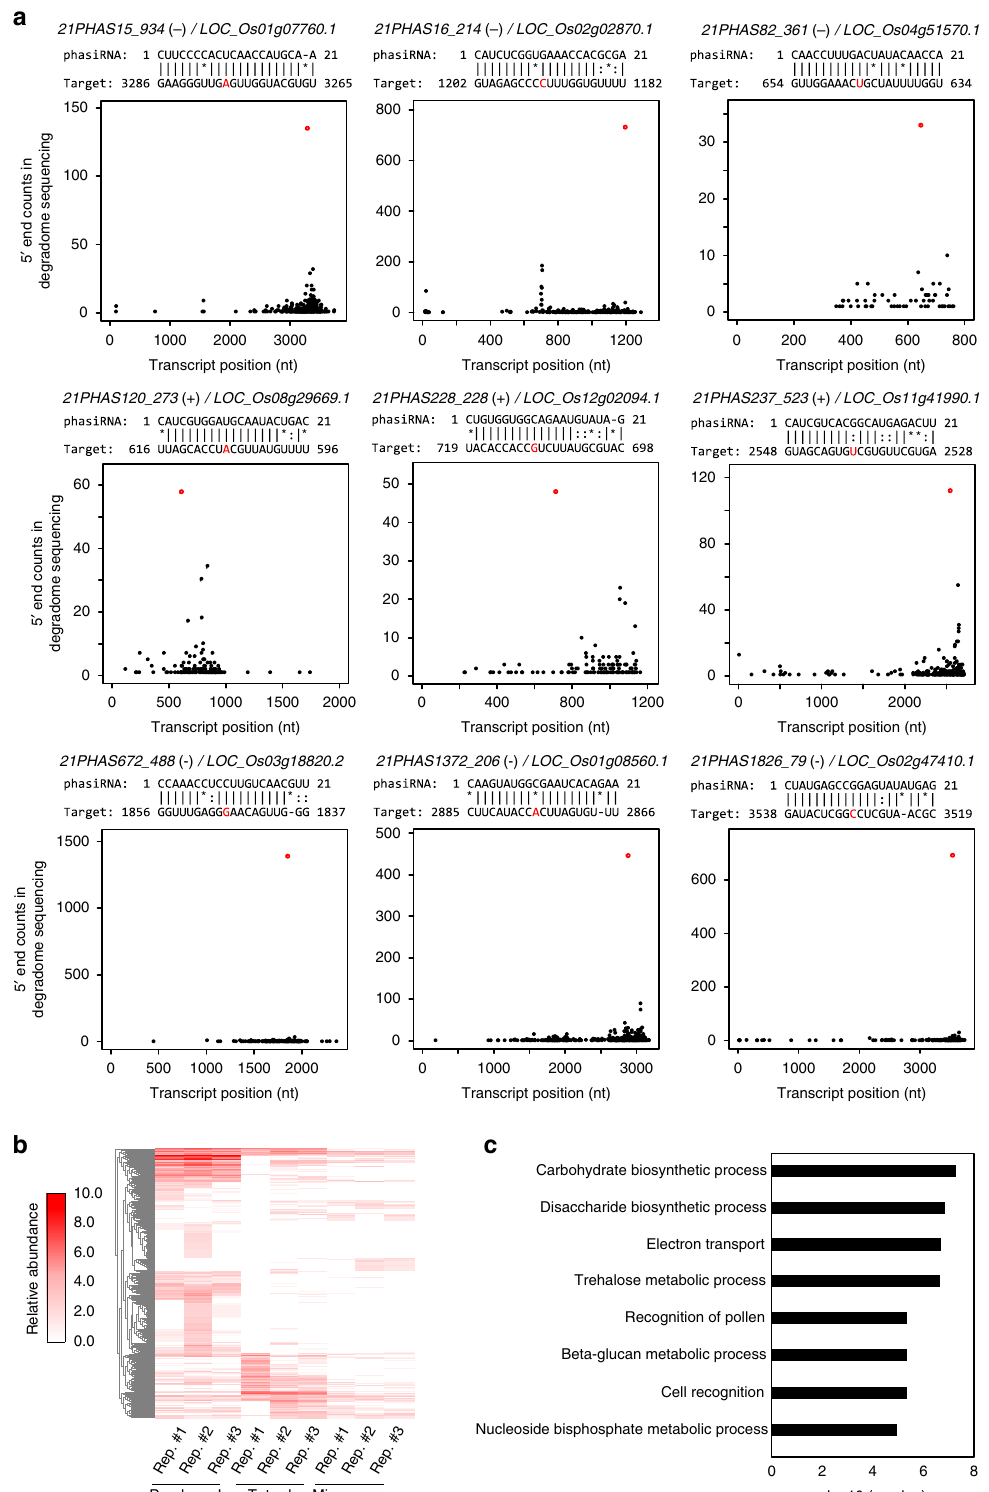
Fig. 3 21-nt phasiRNAs direct target mRNA cleavage. a Plots showing the distribution of the degradome tags along representative 21-nt phasiRNA targets. The x axis represents the nucleotide position of each target mRNA (5 ′ – 3 ′ ). The y axis represents the relative frequency of degradome tags. The red dot represents degradome tag at + 1 position of 21-nt phasiRNA-guided cleavage site. b Heatmap showing the abundances of degradome tags at + 1 positions of 21-nt phasiRNA-guided cleavage sites in early prophase I meiocytes, tetrads and microspores. Colors represent RP10M (Reads Per 10 Million) values that are log2-transformed after adding a pseudocount of 1. c Gene ontology enrichment analysis of the validated 21-nt phasiRNA targets in early prophase I meiocytes. GO biological process terms signi fi cantly enriched in the target genes are shown. The P values were calculated by using Fisher ’ s exact